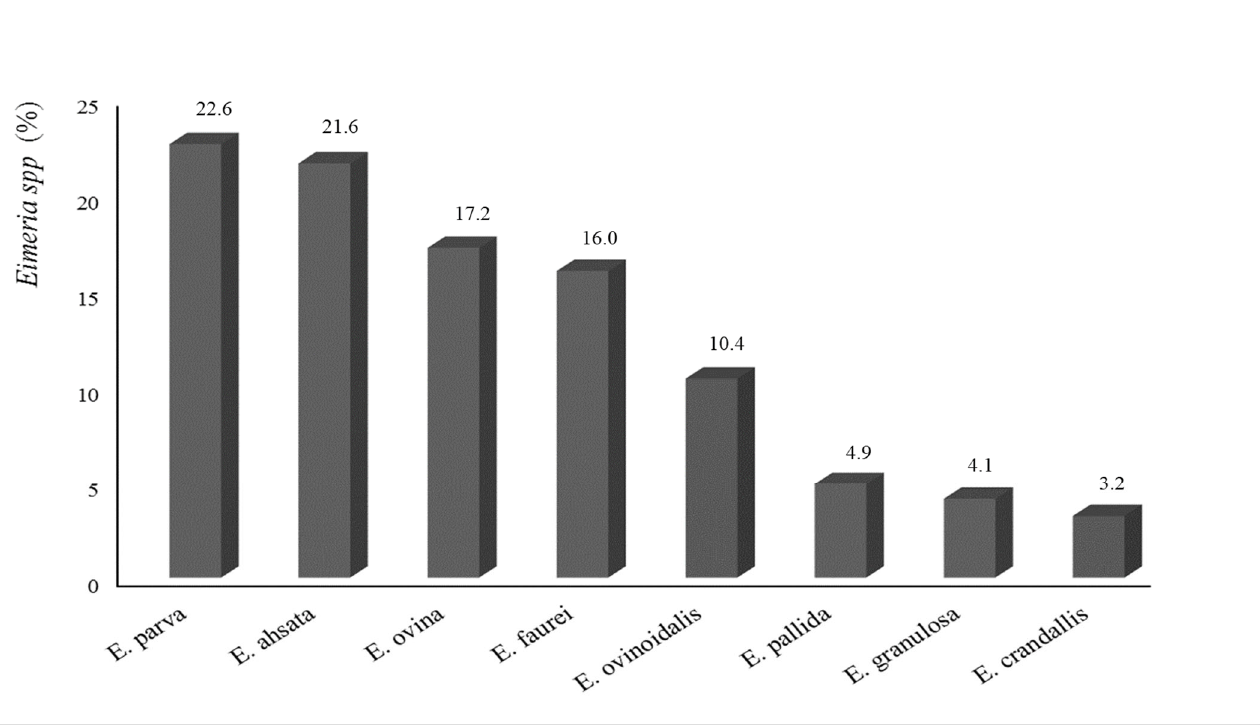
Table 2. Excretion of coccidial oocysts per gram of faeces (opg) in each experimental group. Treatment